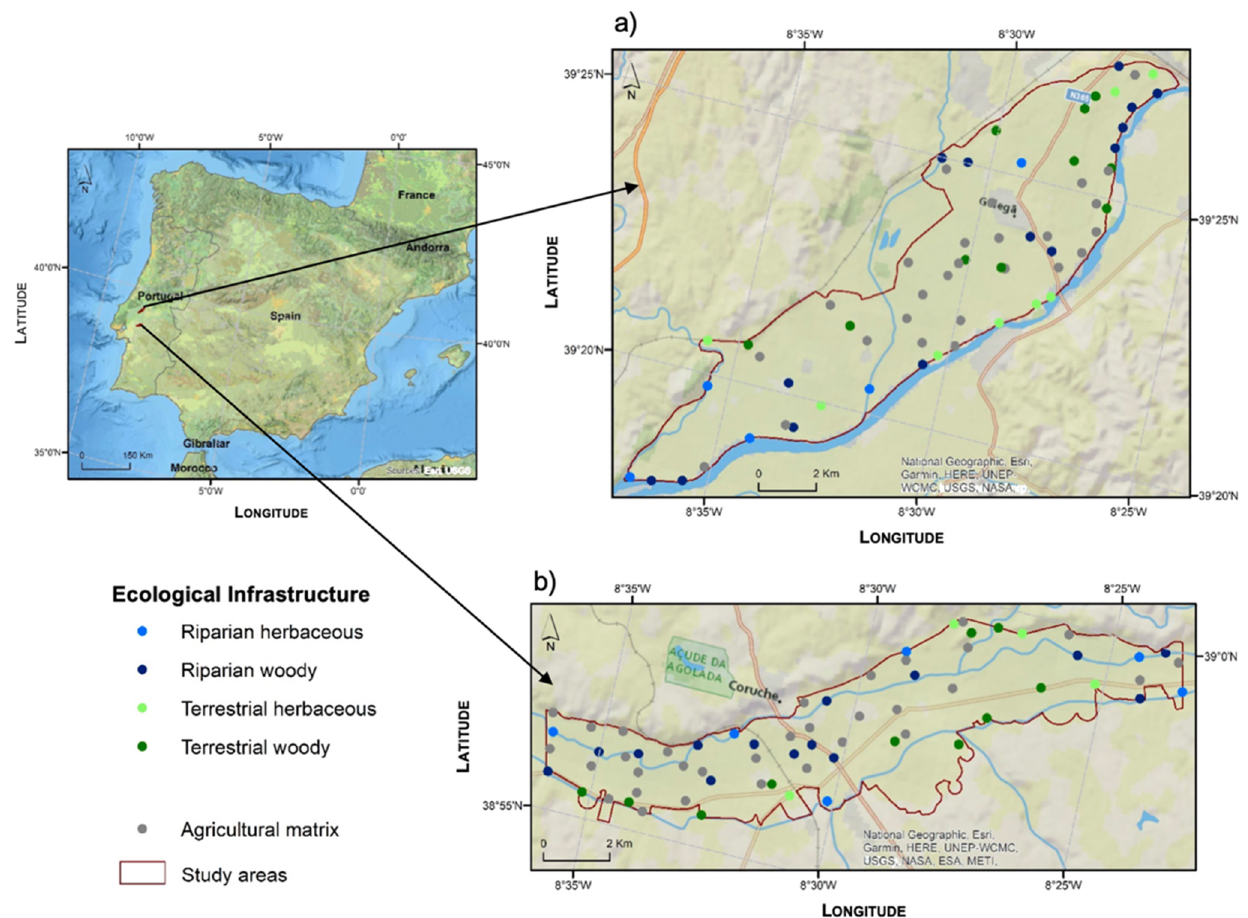
Figure 1. Geographic location of study areas and sampling sites. ( a ) Tagus and ( b ) Sorraia valleys.